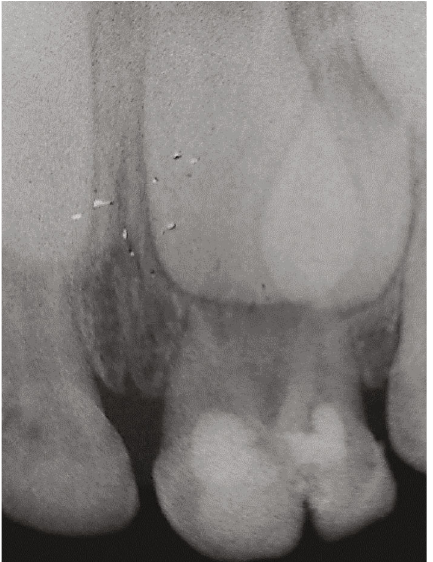
Figure 5: Periapical radiograph of the geminated tooth 61 and its contiguous tooth 62 at the 9-month follow-up visit: the presence of sealed coronal restoration of the two primary teeth with no pathological signs.